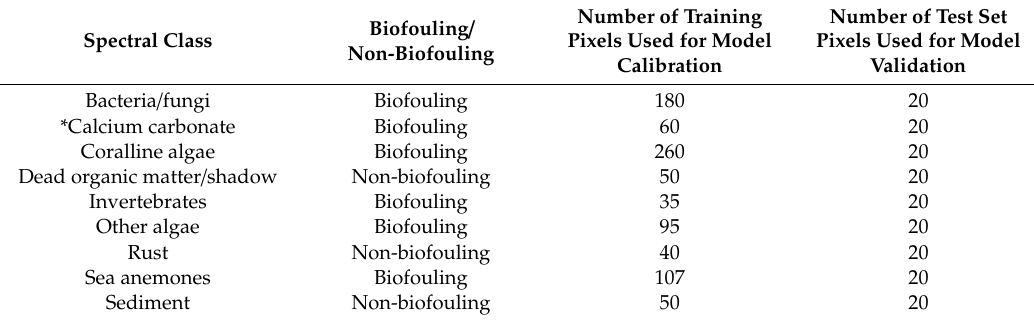
Table 1. Number of training pixels obtained from nine distinct spectral classes assumed to be present in the internal average relative reflectance (IARR)-converted underwater hyperspectral imaging (UHI) transect from the Figaro wreck site. Six of the nine spectral classes were assumed to be biofouling classes. The table shows the number of pixels used for both calibration and validation of the supervised classification